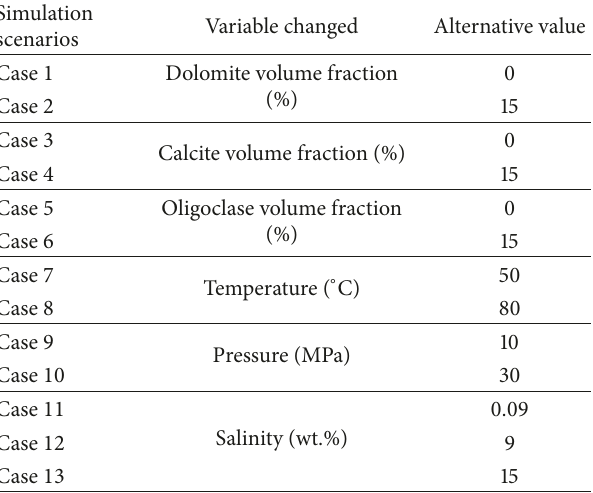
Table 4: Summary of the simulation